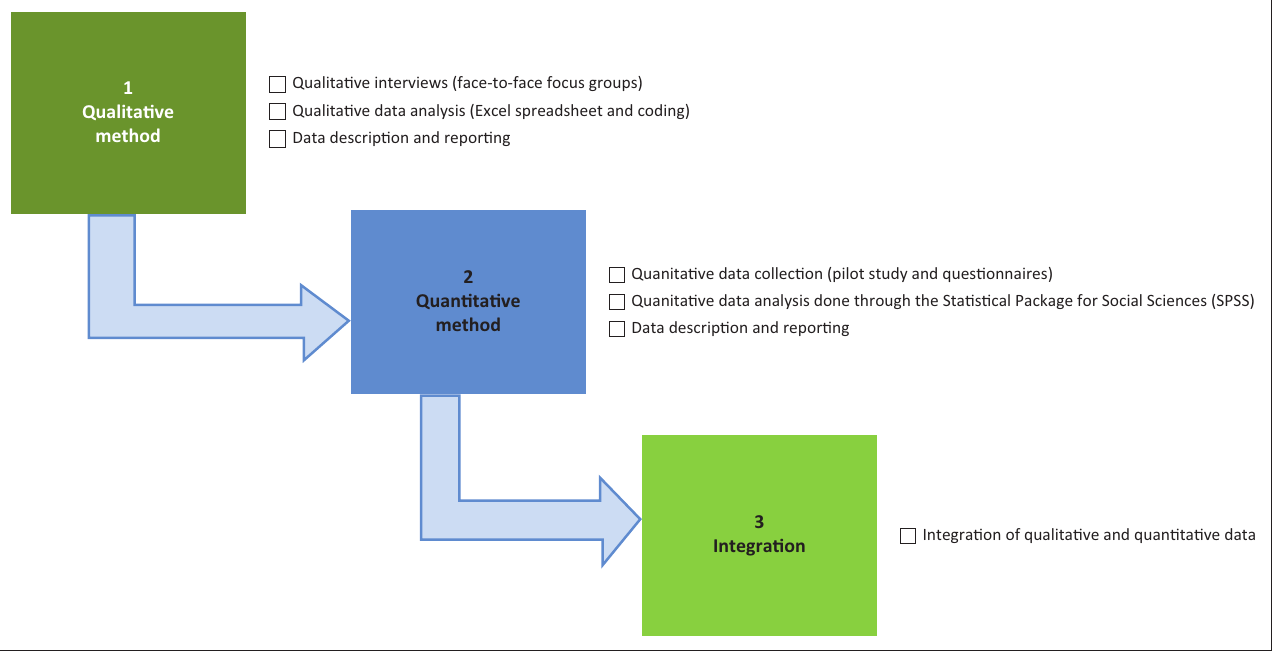
FIGURE 3: Sequence for application of